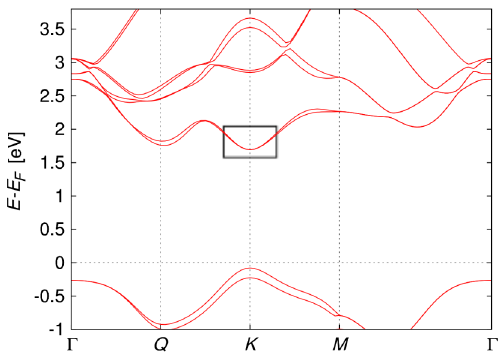
FIG. 1 Schematics of a QD defined with the help of four top gates in a monolayer TMDC. S and D denote the source and the drain, respectively.